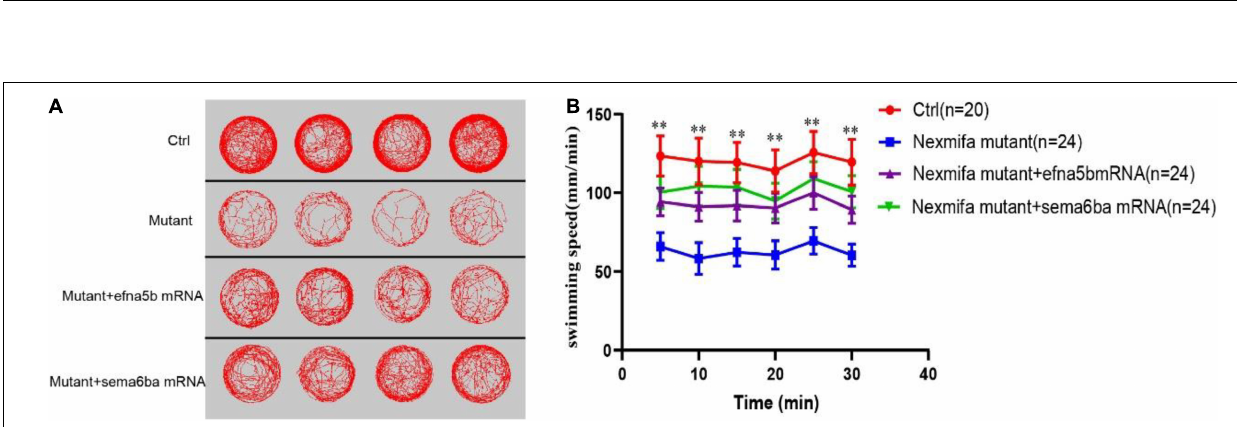
Frontiers in Molecular Neuroscience |